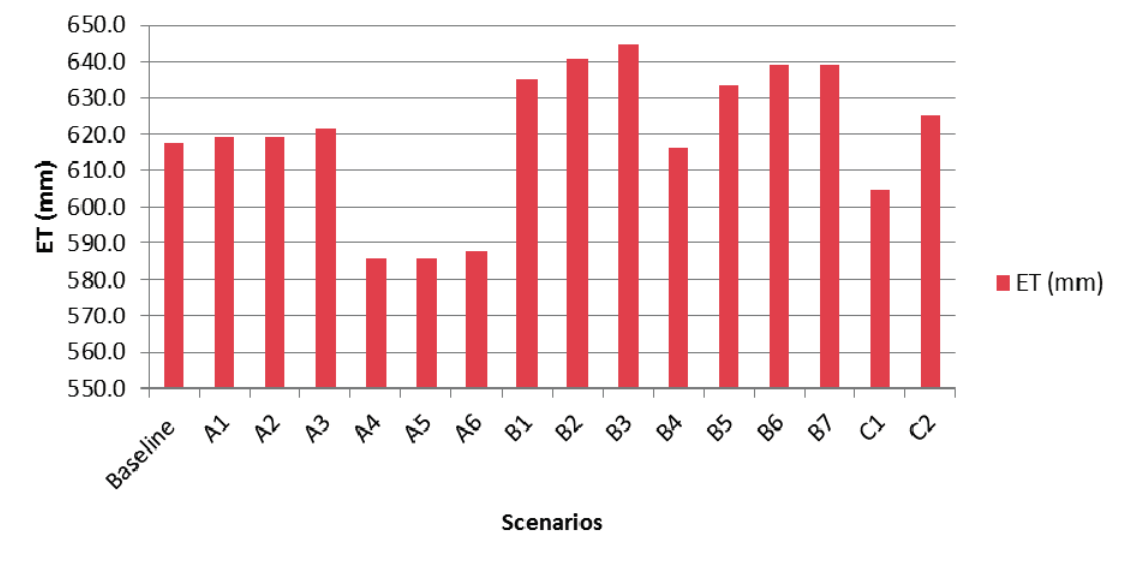
Figure 6. Annual average water consumption through evapo-transpiration (ET) at the watershed scale under the 15 different